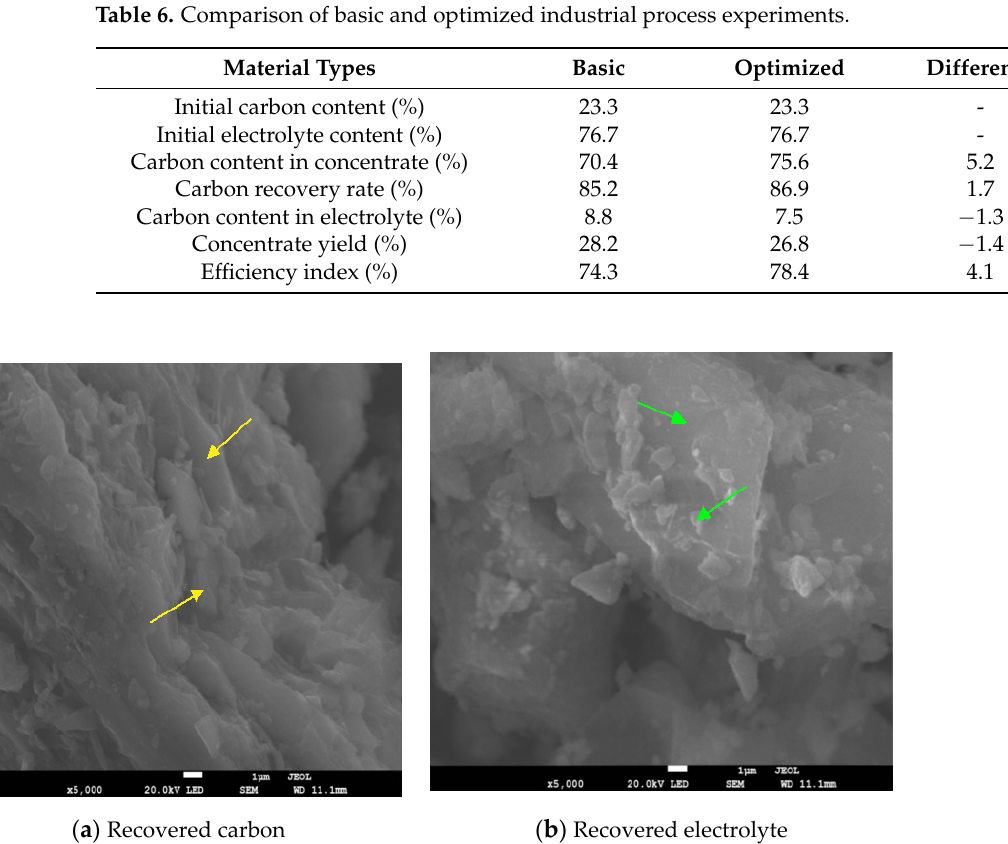
Figure 12. Effect of mixing time on flotation.